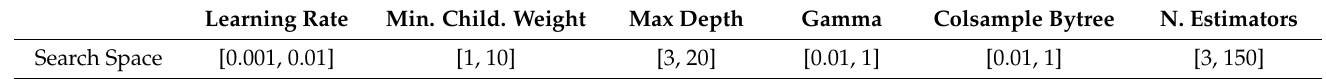
Table 1. Search space for hyperparameters optimization of XGBoost. Learning Rate Min. Child. Weight Max Depth Gamma Colsample Bytree N. Estimators Search Space [0.001,